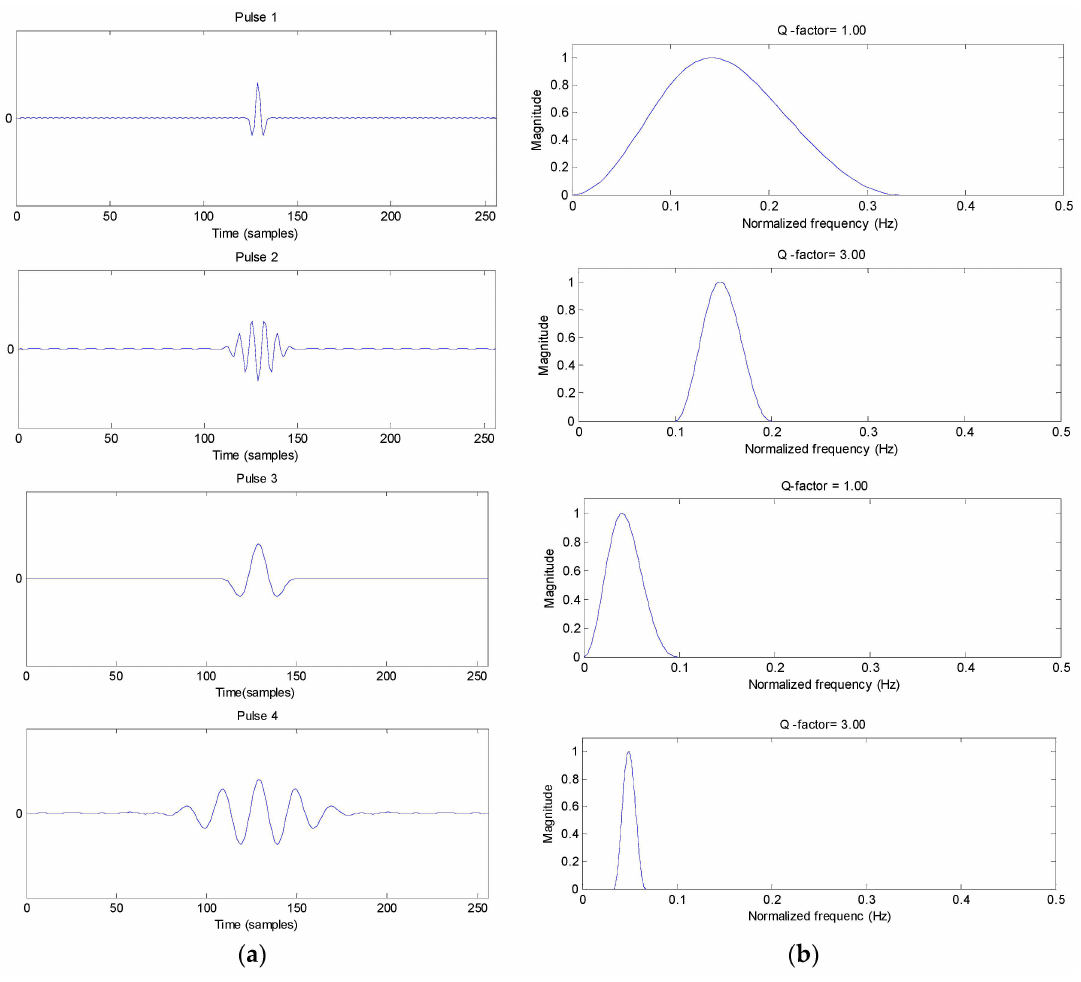
Figure 1. The resonance property of a signal. ( a ) Signals; ( b ) Frequency